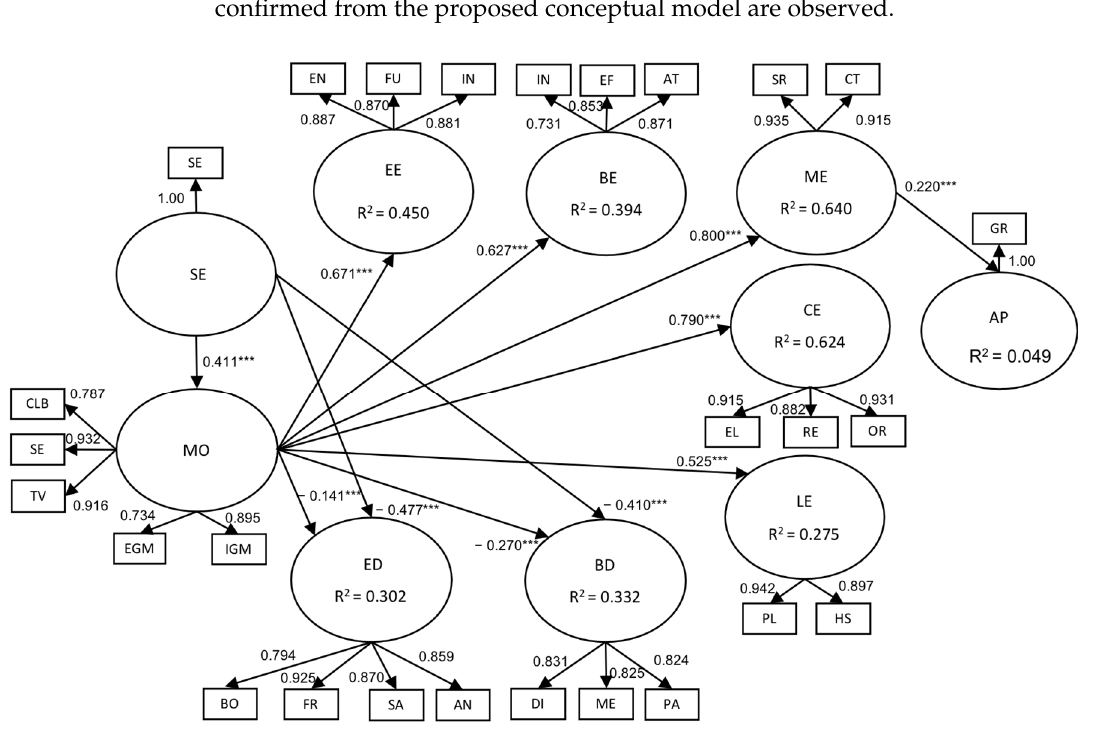
Figure 2. Significant relationships of the causal model *** p < 0.001.